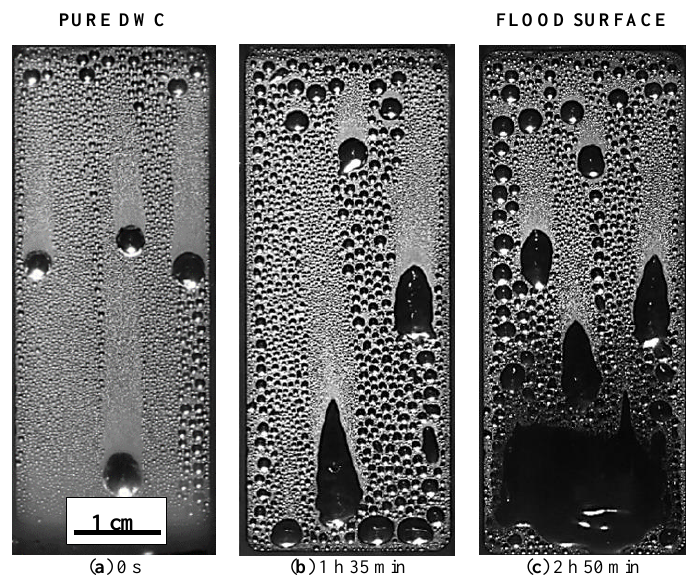
Figure 8. Images recorded during condensation tests on M7T3_300 at a different time steps: ( a ) at the beginning of the experiment, ( b ) after 1h and 30min, ( c ) after 2h and 50min.